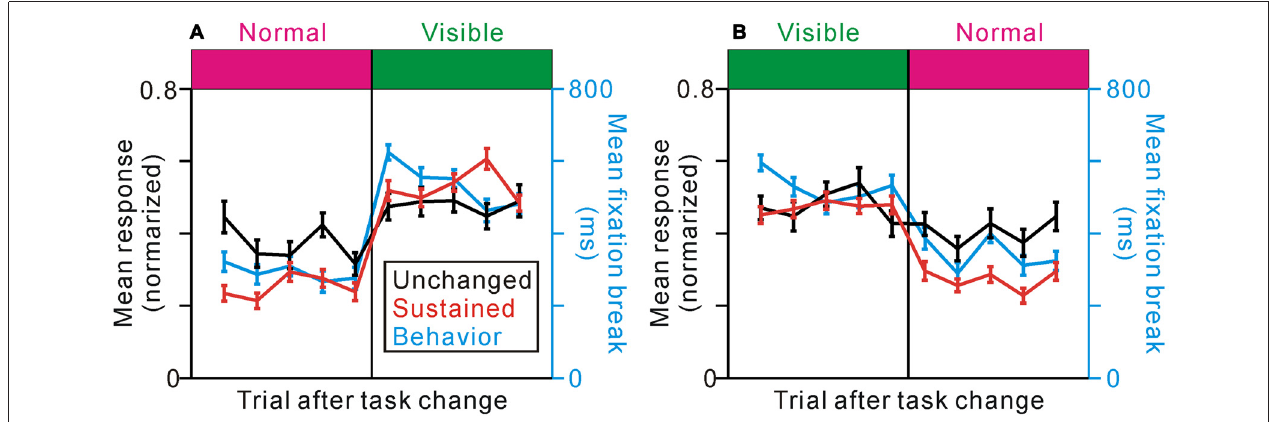
FIGURE 6 | Effects of task change on the response of unchanged- (black) and sustained- (red) type neurons and on the fixation behavior (cyan) in the change from the normal to visible (A) and the visible to normal (B) conditions. The responses represent the average firing frequencies collected from 0 ms to 600 ms after the reward delivery, normalized to the peak responses of the individual